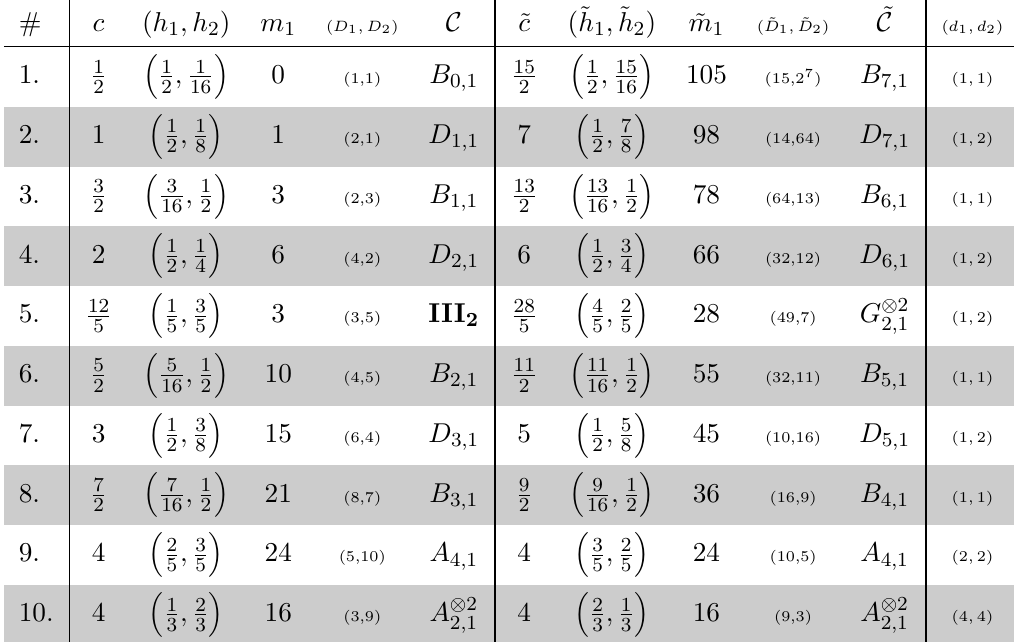
Table 3. CFT pairings, c H = 8 with ( n 1 , n 2 ) = (1 , 1) . The meromorphic theory H to which the solutions pair up is E . 8 , 1